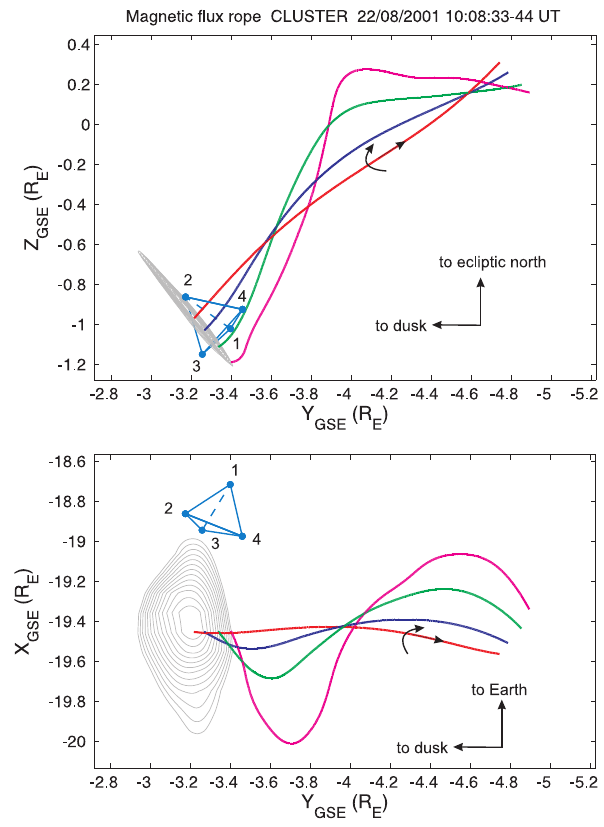
Fig. 3. Combined magnetic field map from C2 and C3 (Fig. 2d), drawn as left-handed spiral field lines in 3-D and placed in a GSE coordinate system. Top: View in the GSE YZ-plane looking toward Earth. The positions of the Cluster tetrahedron is indicated with C1 being the spacecraft displaced most Earthward, i.e. in the plane of the paper. Along the red (almost straight) field line the axial field direction is indicated and how the other three field lines spiral around the axis in a left-handed sense. Bottom: The same as above seen in the GSE XY-plane looking toward ecliptic